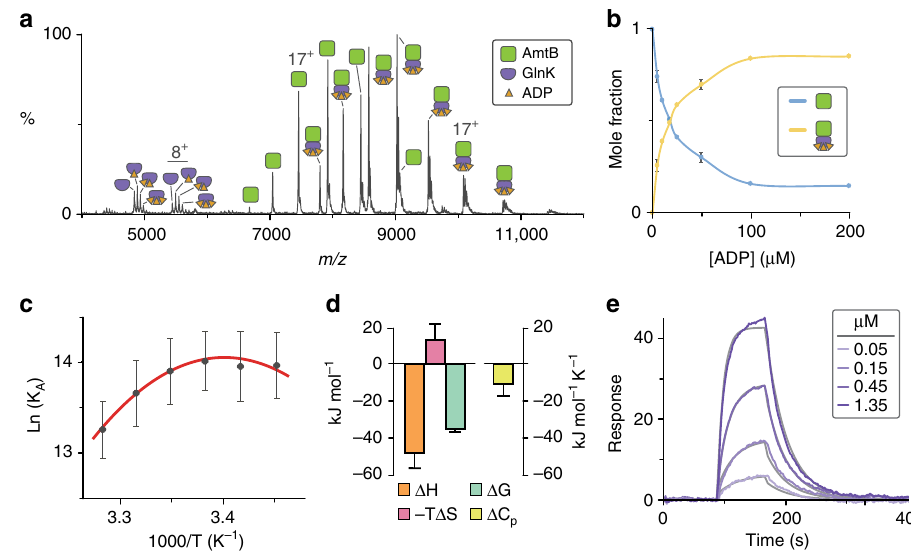
Fig. 1 Biophysical characterization of the AmtB – GlnK complex by native MS and surface plasmon resonance. a Native mass spectrum of AmtB – GlnK at 2 μ M in the presence of 50 µ M ADP. b The effect of ADP concentration on GlnK association with AmtB determined by native MS. Plot of the mole fraction of AmtB and AmtB – GlnK as a function of total ADP concentration. Reported are the average and s.e.m. from repeated measurements ( n = 2). c van ’ t Hoff plot for AmtB – GlnK binding in buffer containing 50 µ M ADP (gray dots) as determined by native mass spectrometry and resulting fi t ( R 2 = 0.98) of the nonlinear “ van ’ t ” Hoff equation (red line). Reported are the average and s.e.m. from repeated measurements ( n = 4). d Thermodynamic signature of AmtB – GlnK binding derived from native MS in the absence of lipid at 298K. Reported are the average and s.e.m. from repeated measurements ( n = 4). The change in free energy ( Δ G ) was calculated directly from repeated measurements of K D,AG at 298K, and entropy ( Δ S ) was back calculated using both Δ H and Δ G (Supplementary Table 1). e Representative sensorgrams of AmtB injected at different concentrations over a sensor surface immobilized with GlnK at 298K (purple lines) and resulting fi t of a Langmuir 1:1 binding model (gray lines). Reported are the average and s.e.m. from repeated measurements ( n =